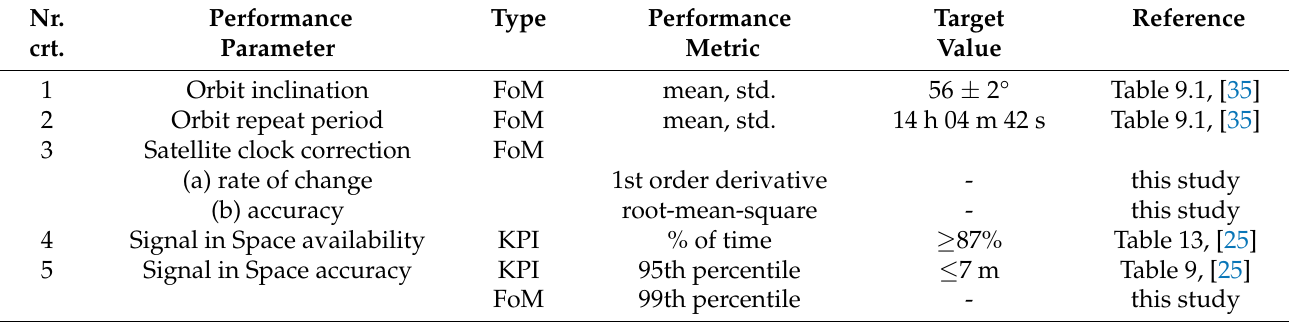
Table 2. Performance parameters and their associated metrics used in this